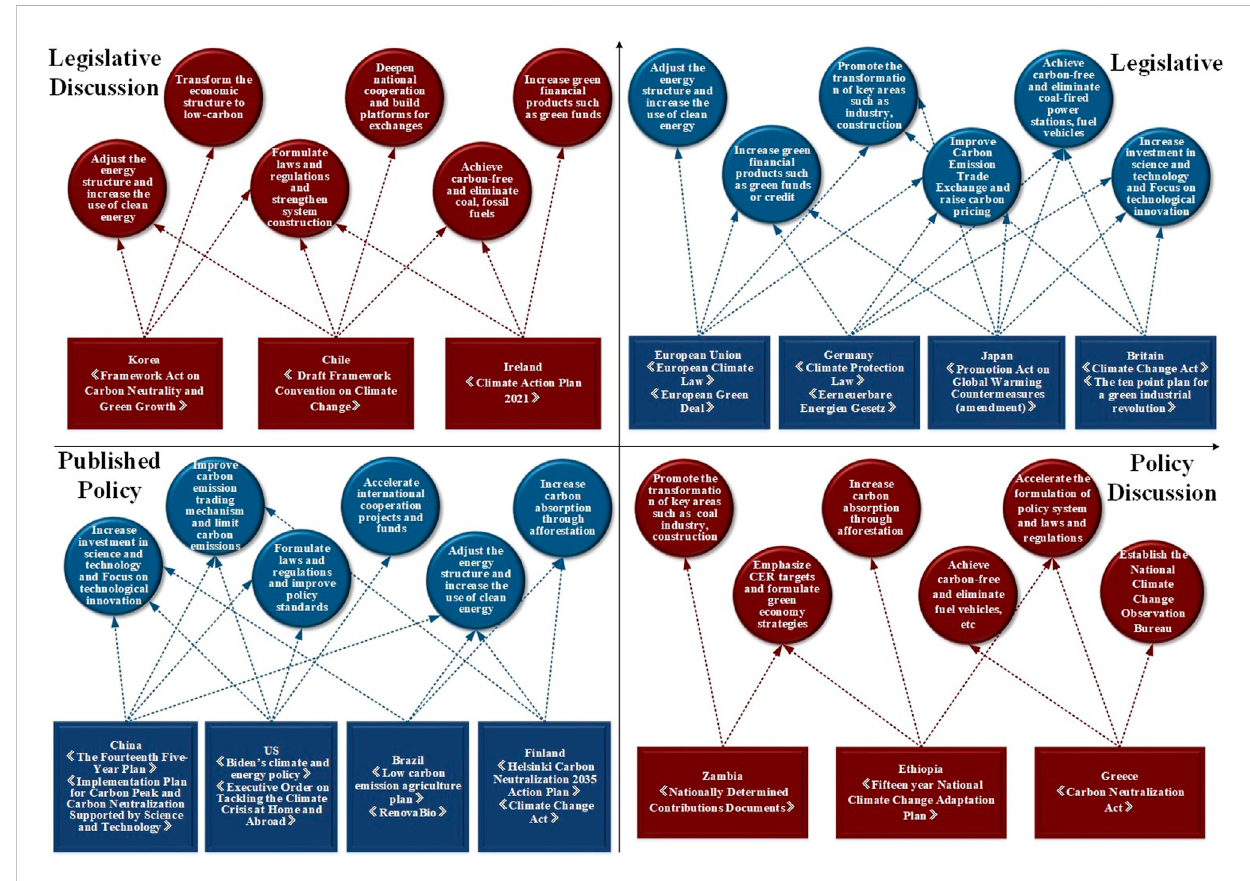
FIGURE 1 Speci fi c measures taken by different countries and regions to achieve carbon